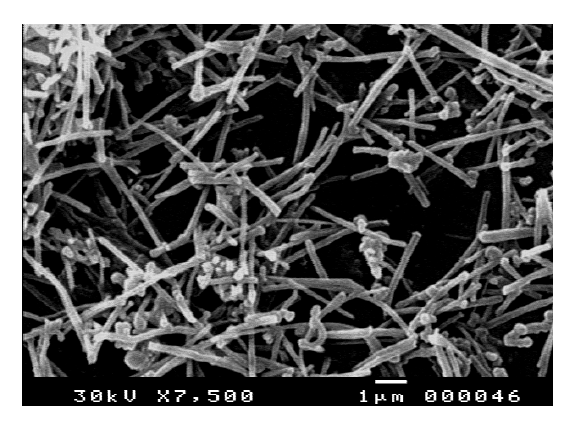
Figure 1: SEM morphology of a PGA/MWCNT film nanocomposite at 7,500 magnification.